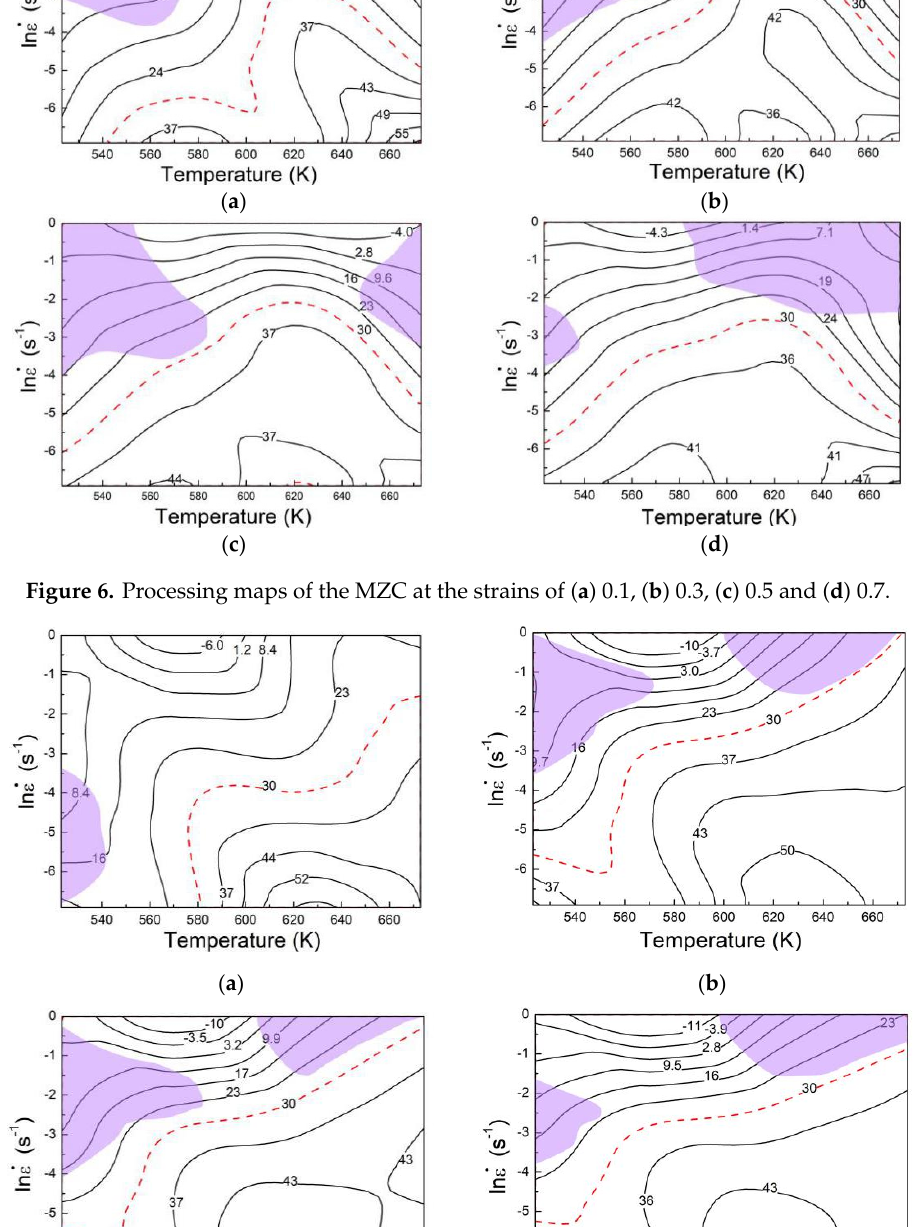
Figure 6. Processing maps of the MZC at the strains of ( a ) 0.1, ( b ) 0.3, ( c ) 0.5 and ( d ) 0.7.